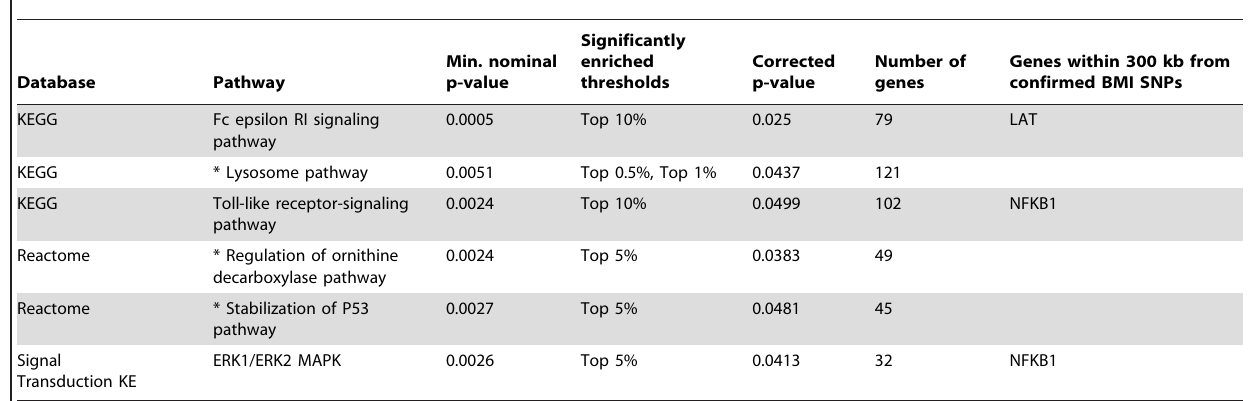
Table 2. Pathways with significant enrichment for associations in the replication set after correcting for multiple testing.